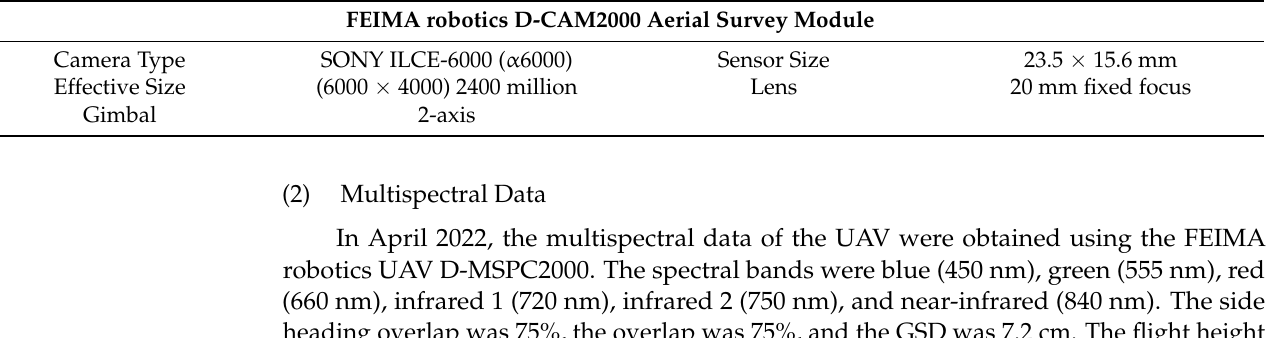
Table 4. Parameters of orthophoto data acquisition.